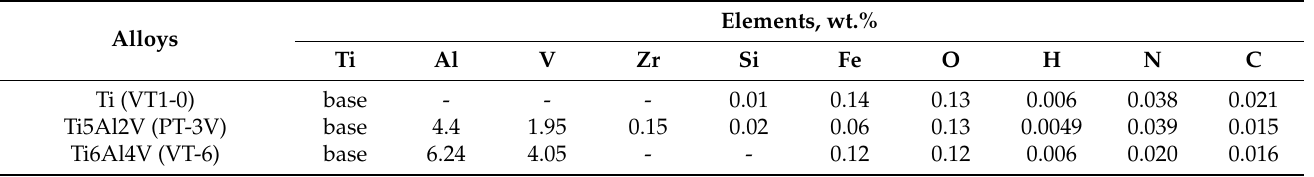
Table 2. Chemical composition of the initial powders (vendor’s certificate